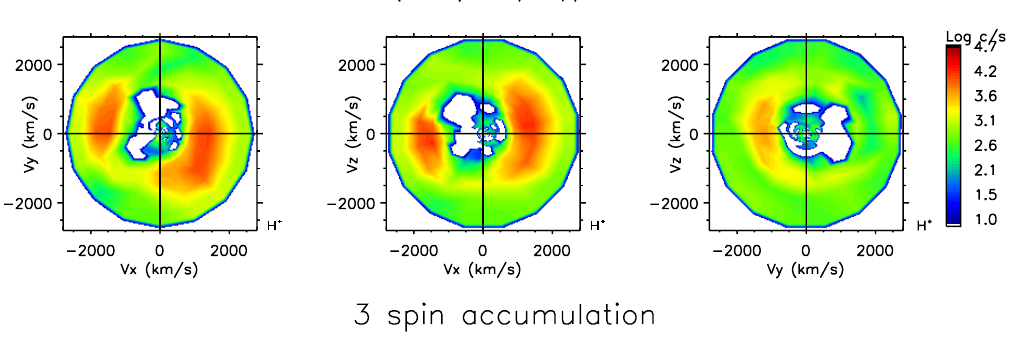
Fig. 25. CODIF H + distribution function (accumulation over 3 spins) in GSE coordinates on spacecraft 3 on 30 September 2000 at 03:04:31UT.